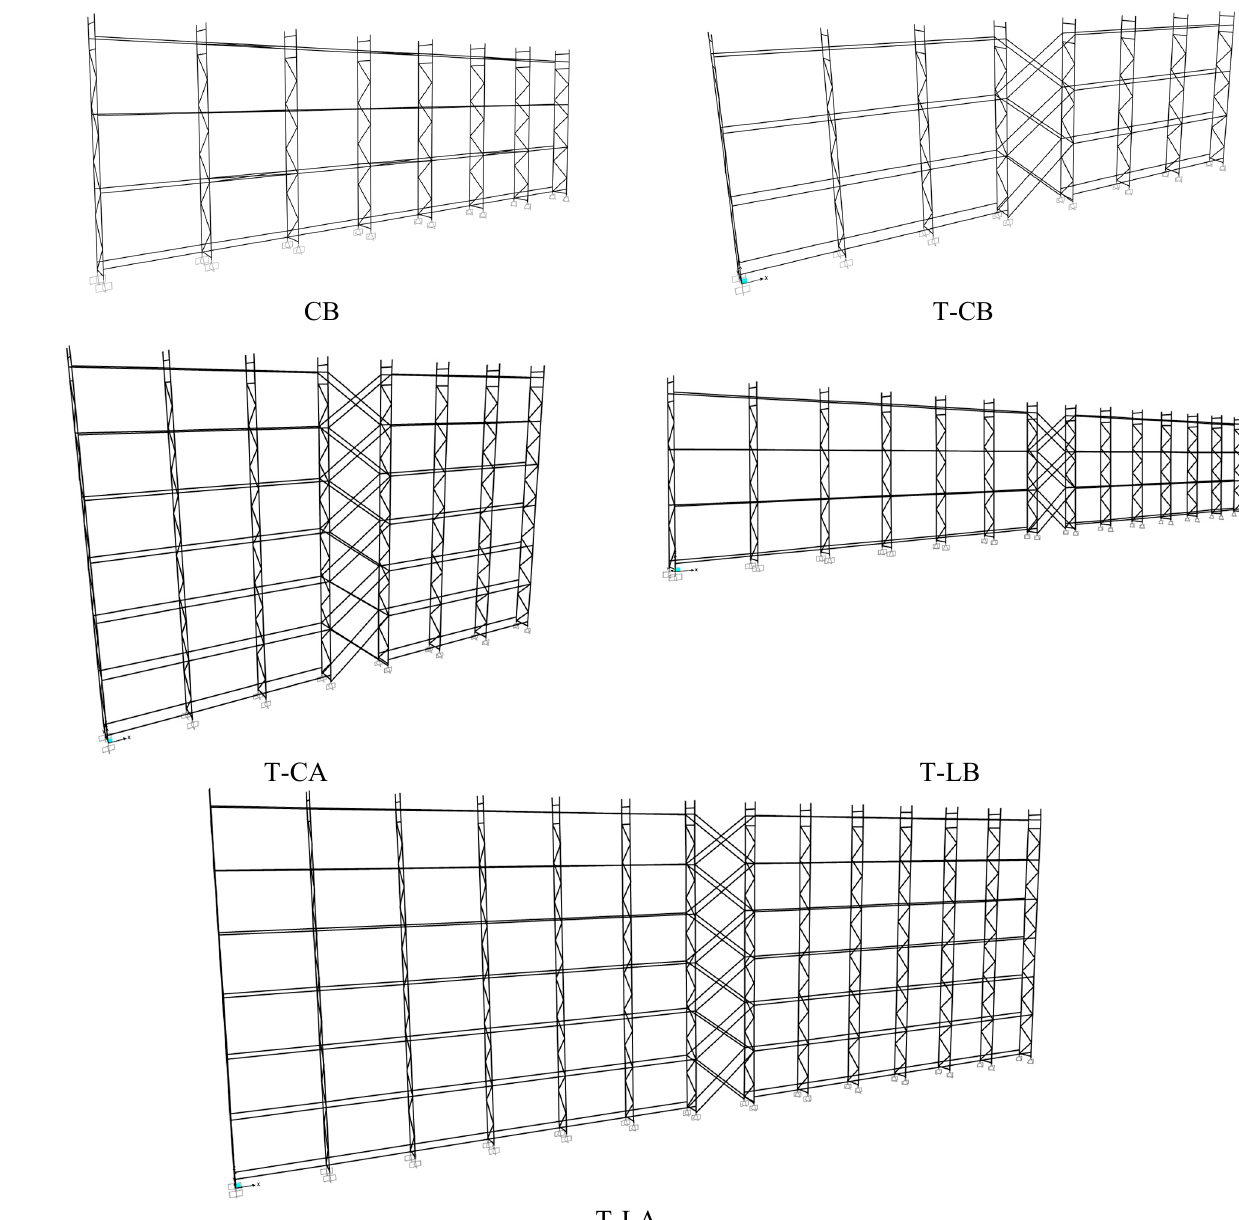
Figure 1. Schematic view of models studied. Table 1. Summary of slenderness parameters in rack structures studied.